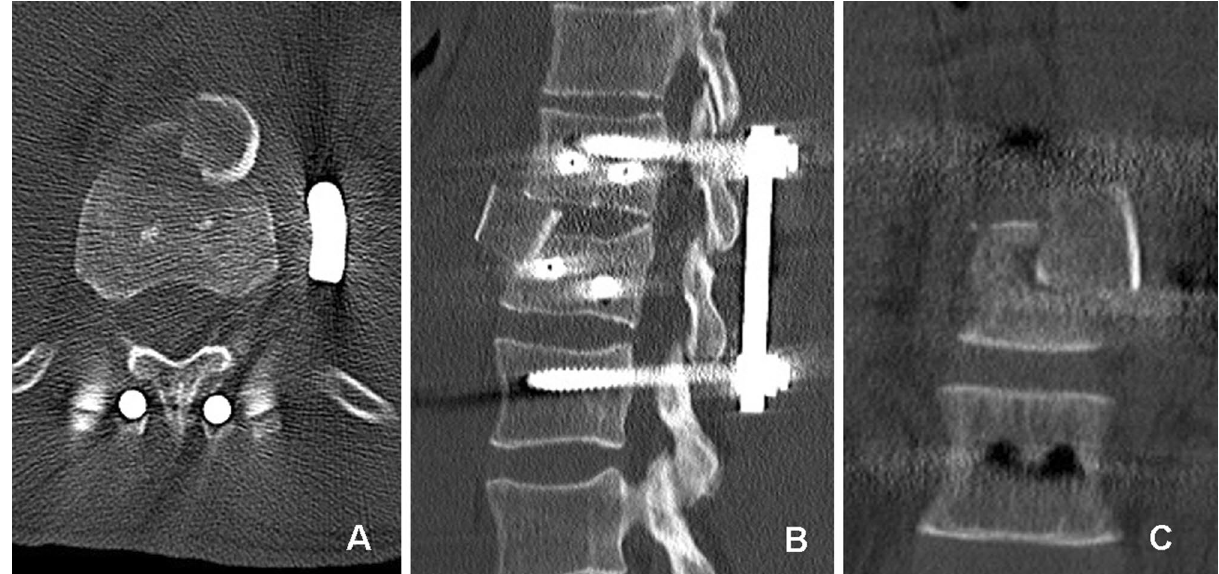
Figure 8. Postoperative CT of the thoracolumbar junction showing a dislocation of the iliac crest bone graft, which was caused by the caudal-anterior screw of the plating